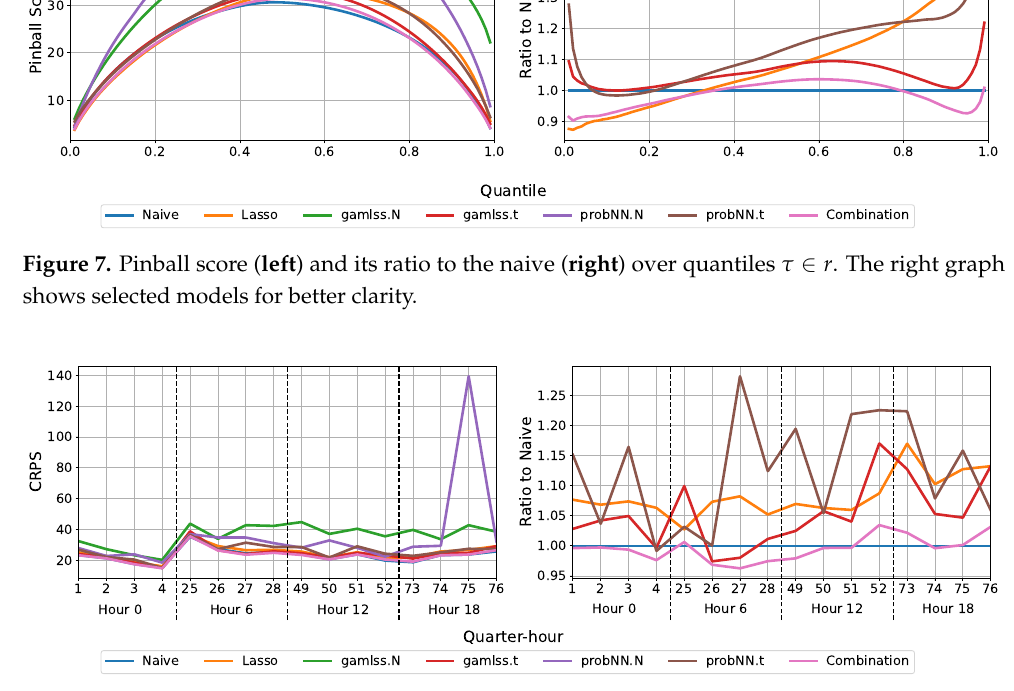
Figure 8. CRPS ( left ) and its ratio to the naive ( right ) over quarter-hours qh ∈ QH . The right graph shows selected models for better